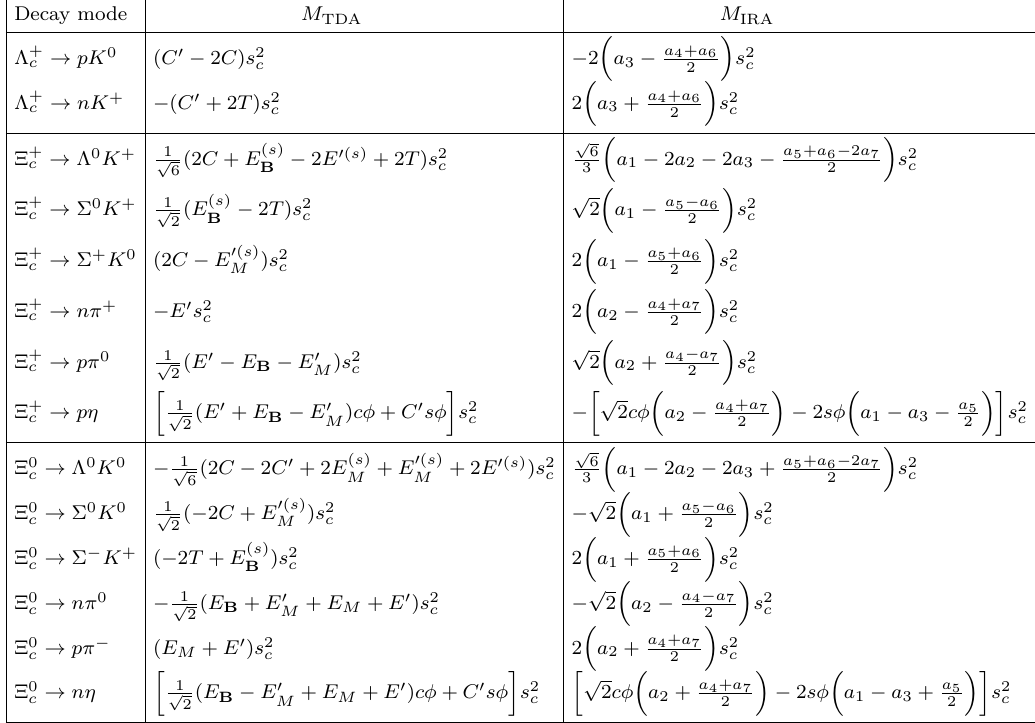
Table 3 . Doubly Cabibbo-suppressed (DCS) amplitudes in the expansions of M TDA and M IRA .